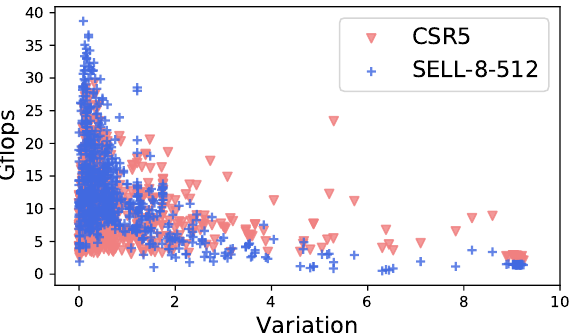
Figure 2. SpMV performance of SELL-8-512 and CSR5 for SpMV performs on matrices with different irregularities (variations). The larger the variation is, the more irregularity a matrix has.